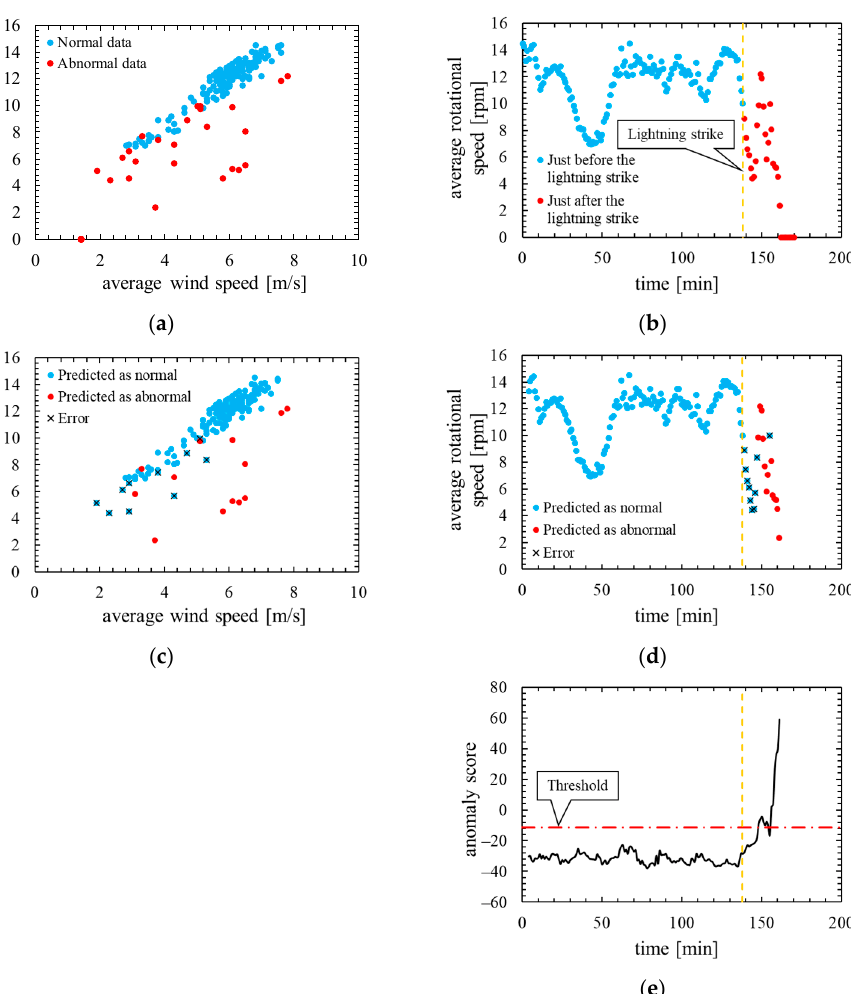
Figure 8. True label and assessment result of the model in which the number of mixture components K was 64 (threshold is the 100th percentile’s value): ( a ) wind speed rotational speed characteristic with true label; ( b ) time characteristics of rotational speed with true label; ( c ) wind speed rotational speed characteristic with predicted label; ( d ) time characteristics of rotational speed with predicted label; ( e ) time characteristics of anomaly score.